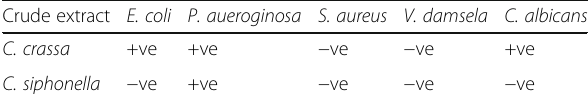
Table 2 Antimicrobial activity of sponge crude